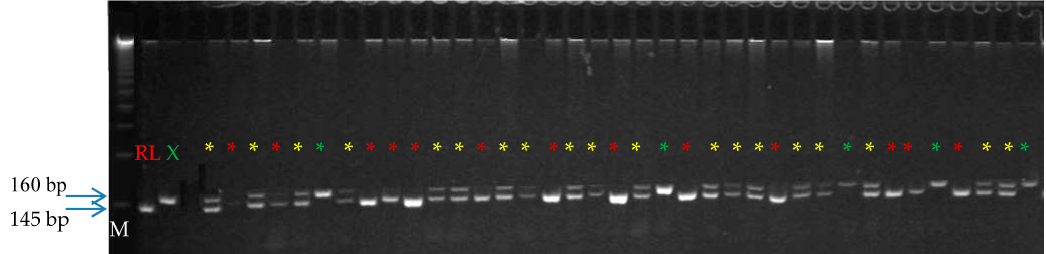
Figure 4. PAGE gel showing PCR amplification using DNAs from seedling of RL × X: yellow labeled zygotic seedlings with bifoliate and trifoliate leaves; red labeled nucellar seedlings; and green labeled zygotic seedlings with extra allele (primer F29). M is molecular marker of 50 bp. Both female and male parents were heteroallelic for the locus, and a total of two alleles appeared on the F29 locus in the F 1 population of RL × X (Figure 4) and four alleles appeared on the F87 locus in the F 1 population of RL × SC (Figure 5). In both the crosses, out of the 170 multifoliate